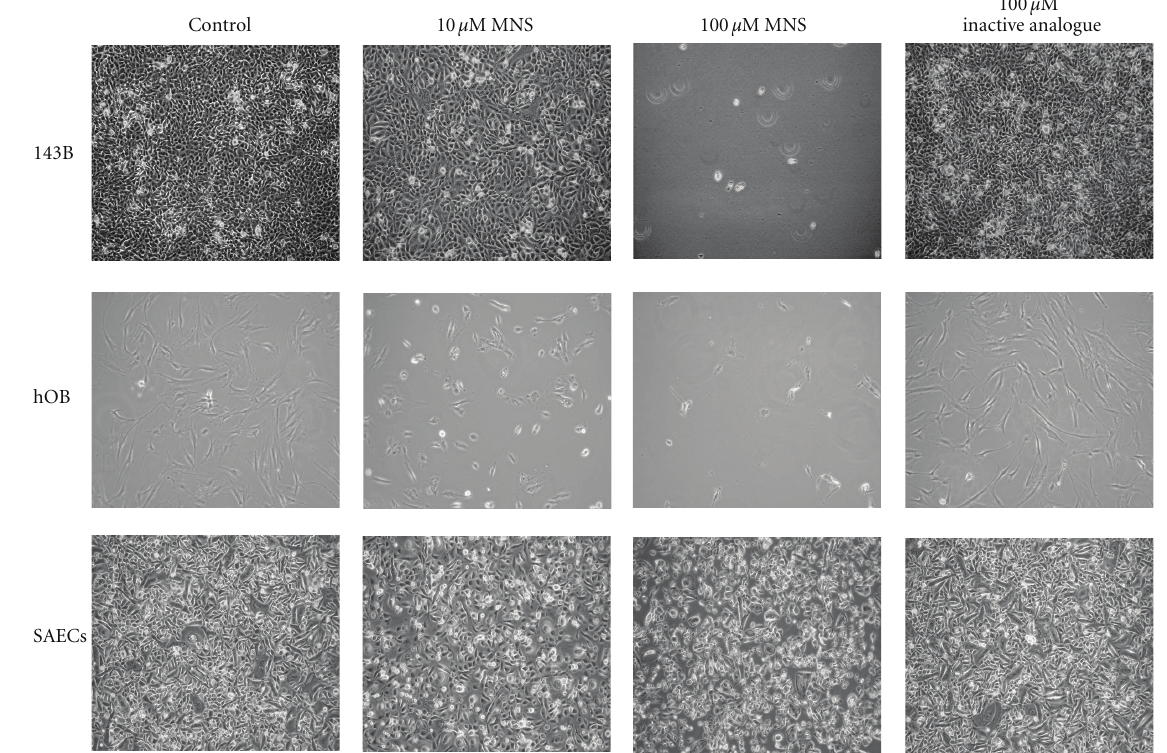
Figure 6: MNS also disrupts monolayers of osteosarcoma cells and osteoblasts but does not alter monolayers of small airway epithelial cells. 143B metastatic osteosarcoma cell line, normal human osteoblasts (hOB), and normal human small airway epithelial cells (SAEC) after culture for 24 hours in the presence of 10 μ M MNS, 100 μ M MNS, 100 μ M of the inactive analogue, or 1% DMSO as a vehicle control. Figure shows representative images from three independent experiments, each with three wells per group.